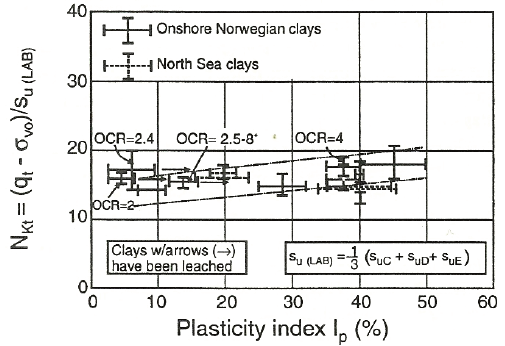
Fig. 3. A dependence between the determined N kt and plasticity index